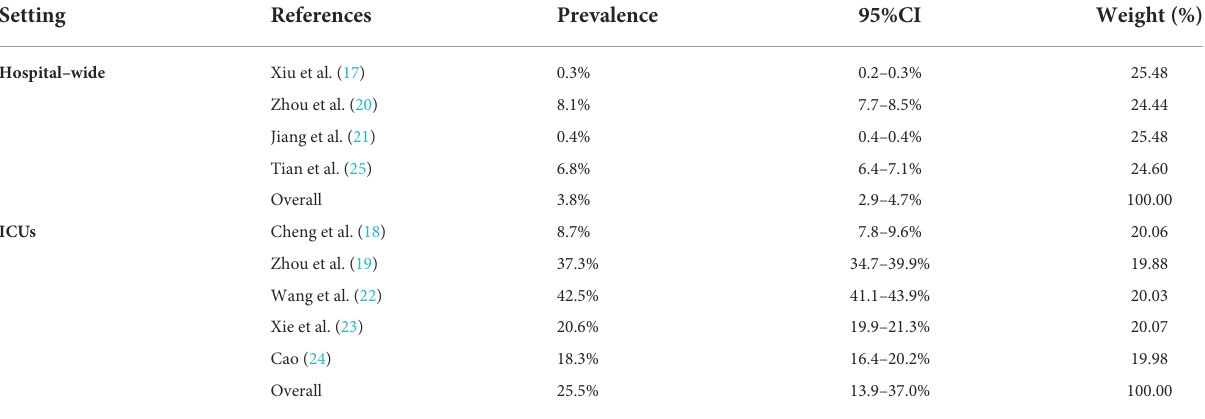
TABLE 5 The prevalence of sepsis in hospital–wide and ICUs in China.